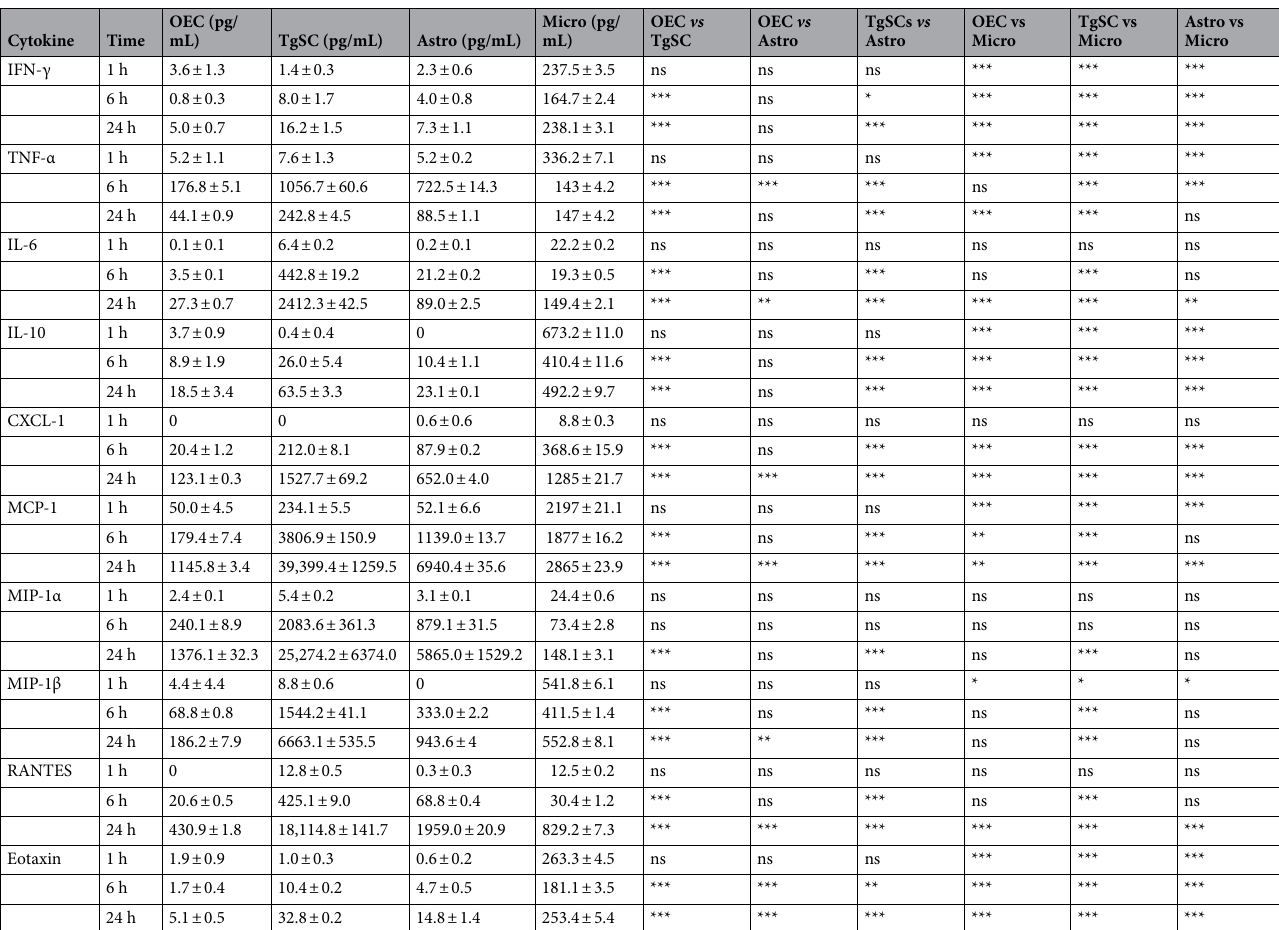
Table 1. Cytokine/chemokine secretion by OECs, TgSCs, astrocytes and microglia post S. aureus exposure with comparison between the glia. (Data shows mean ± SEM. (Two-way ANOVA with Tukey’s